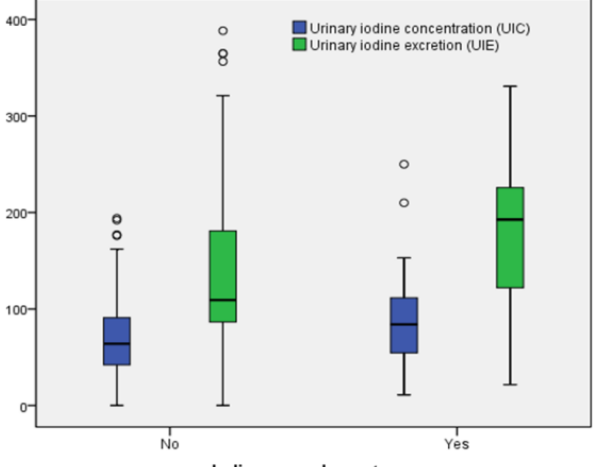
Figure 4. Urinary iodine concentration (UIC, μg/L) and urinary iodine excretion (UIE, μg/24 h) in 119 pregnant women in the Norwegian Mother and Child Cohort Study.